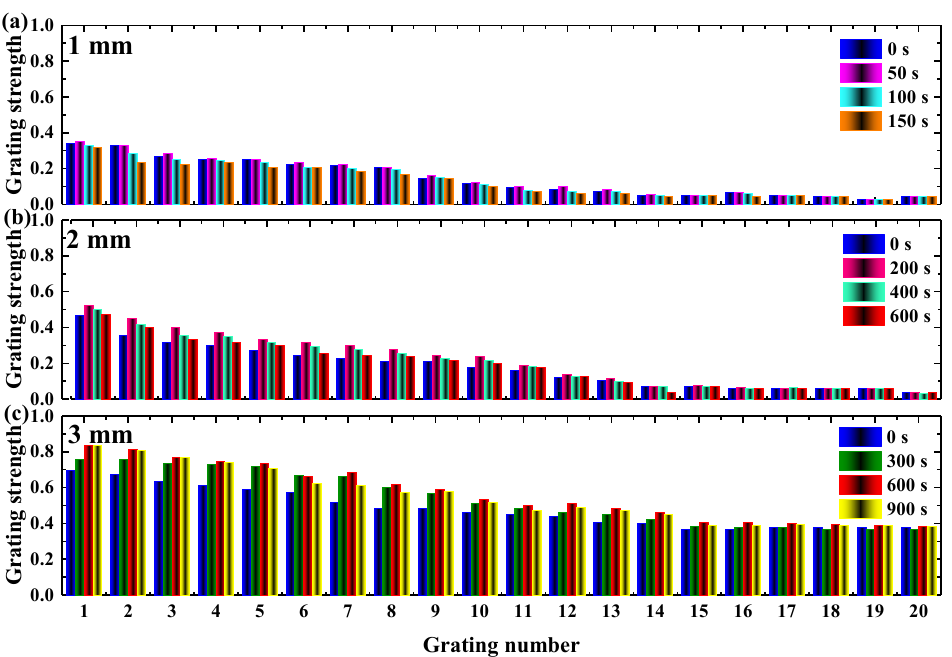
Figure 6. Enhancement of multiplexed gratings in dark diffusion: ( a ) 1 mm, ( b ) 2 mm, ( c ) 3 mm. To investigate further, we measured the total multiplexing grating strengths before and after dark diffusion, as shown in Figure 7. The original grating strengths during the post-exposure process of the 1–3 mm samples were 2.82, 3.37 and 4.85, respectively. During the dark diffusion process, the peak grating strengths of the 1–3 mm thick materials were 2.94, 4.20 and 6.88. The corresponding increment ratios were 4%, 25% and 42%, respectively. Meanwhile, the stabilized grating strengths at the end of the dark diffusion were 2.02, 3.32 and 6.48. The corresponding attenuation ratios were 31%, 21% and 6%. This result indicates that thicker materials contributed high multiplexing capacity and stable storage ability. The lengths of error bars shown in Figure 7b,d,f were 0.1–0.2, 0.05–0.15 and 0.18, respectively.